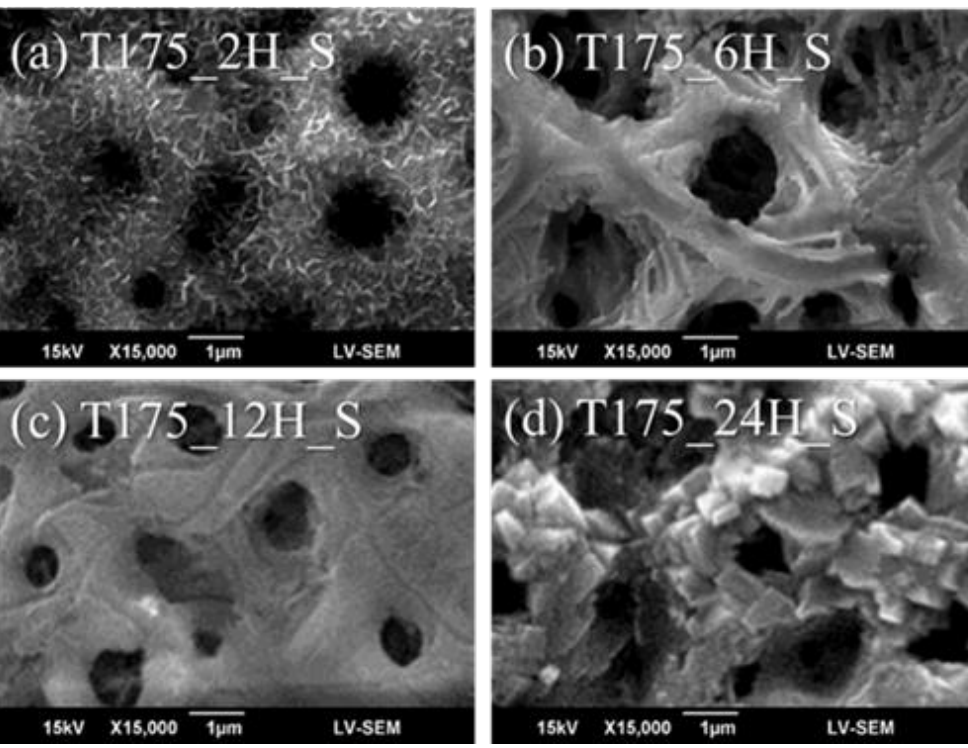
Figure 4. Microstructures of the hierarchical structures fabricated using a hydrothermal treatment at 175 ◦ C for ( a ) 2, ( b ) 6, ( c ) 12, and ( d ) 24 h.